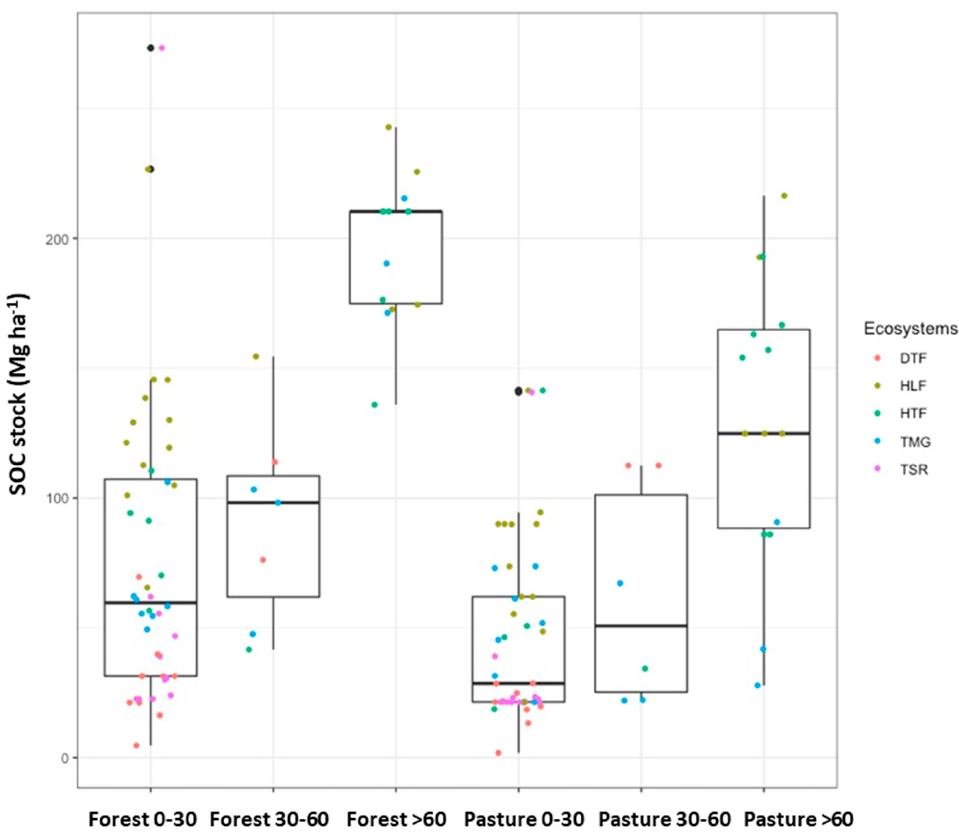
Figure 2. Soil organic carbon stocks between native forests and pastureland by reported depth categories. The native ecosystem types are denoted as follows. DTF: dry tropical forests; HLF: highland forests; HTF: humid tropical forests; TMG: tropical mangroves; TSR: tropical scrubs and rangelands.